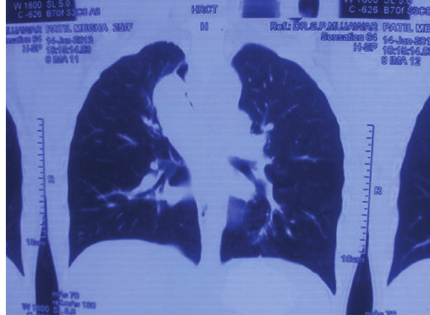
Figure 2: CT scan showing mass around the right side of esophagus extending to left side obliquely, suggestive of esophageal leiomyoma.